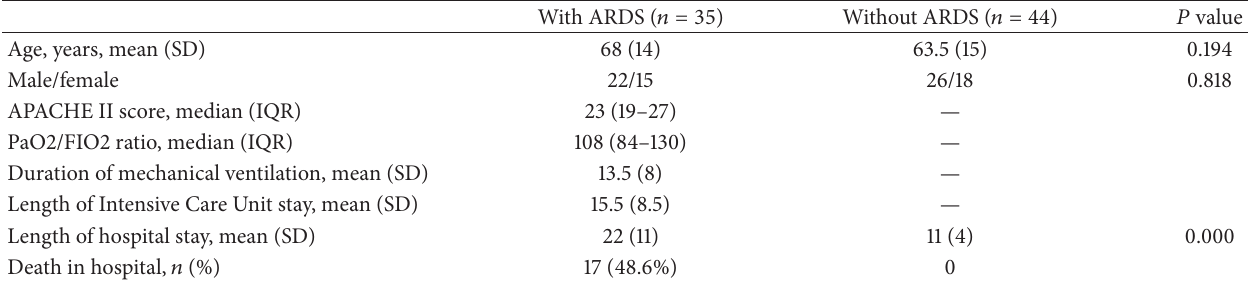
Table 6: Demographic and baseline clinical characteristics of pneumonia with ARDS or without ARDS.